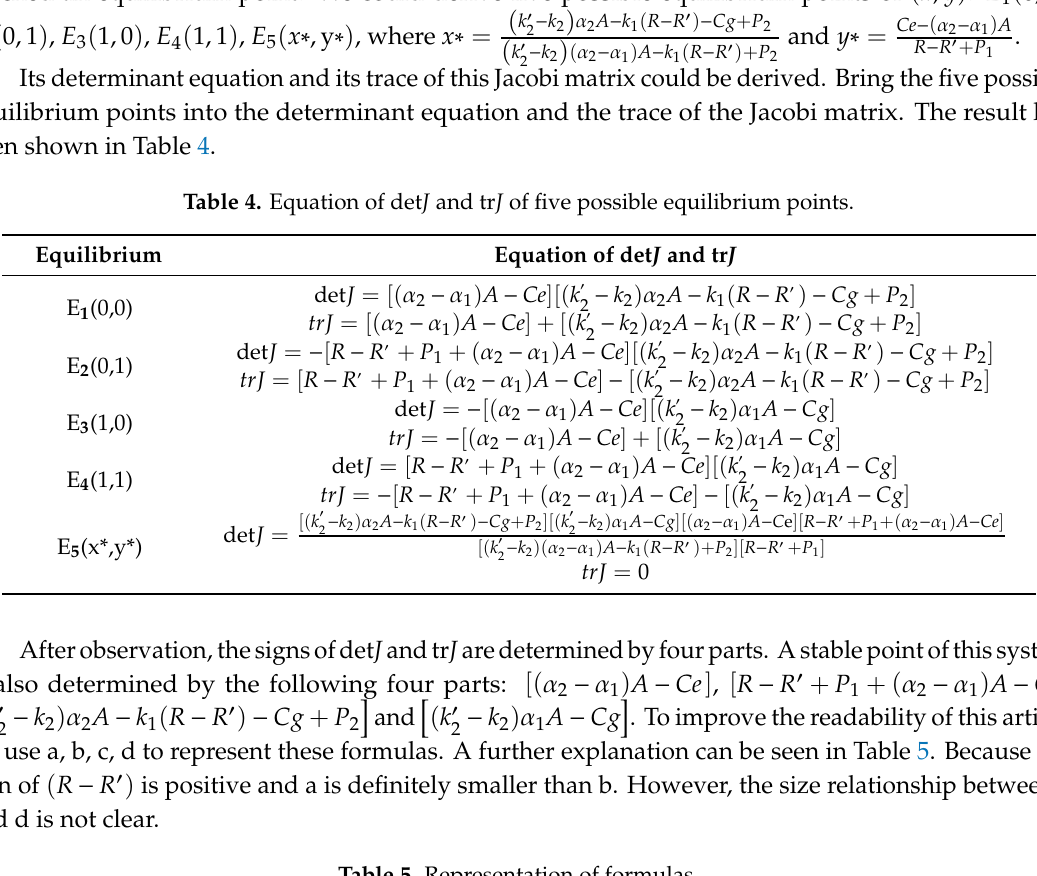
Table 5. Representation of